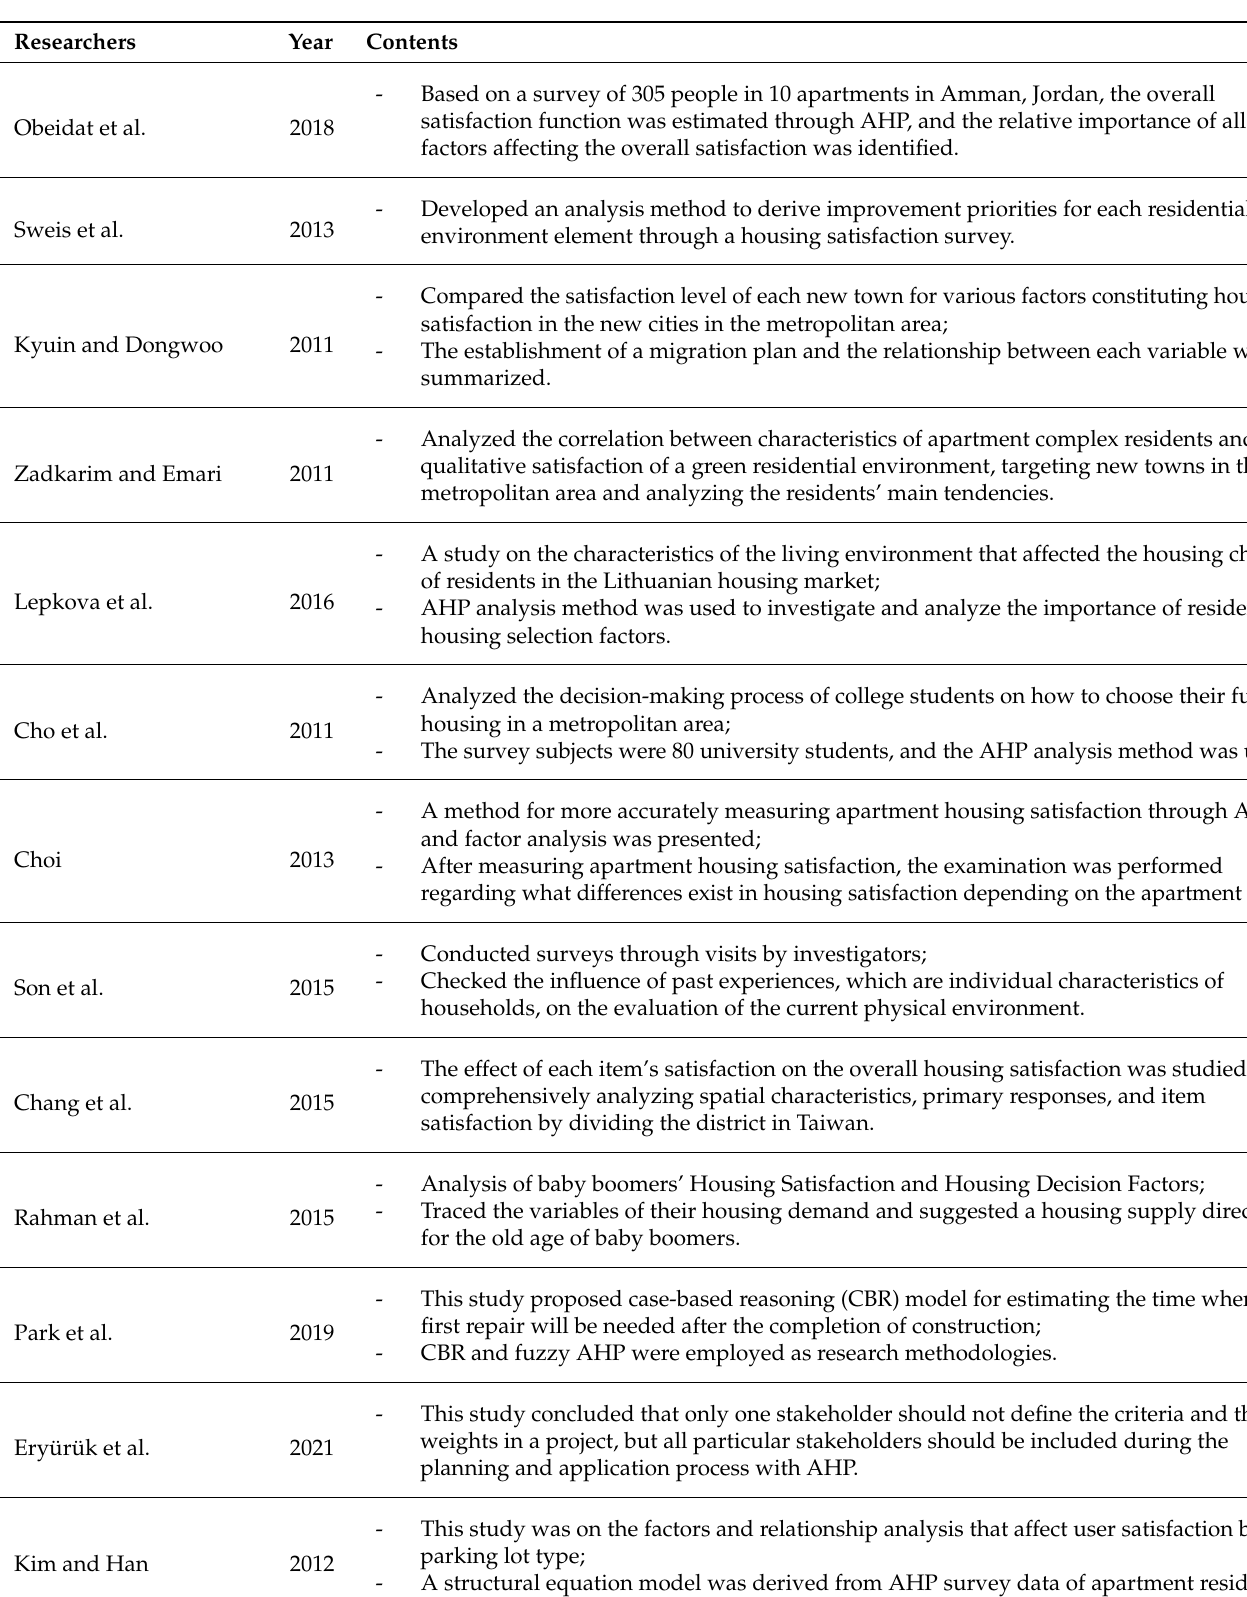
Table 1. The Review of Relevant Previous